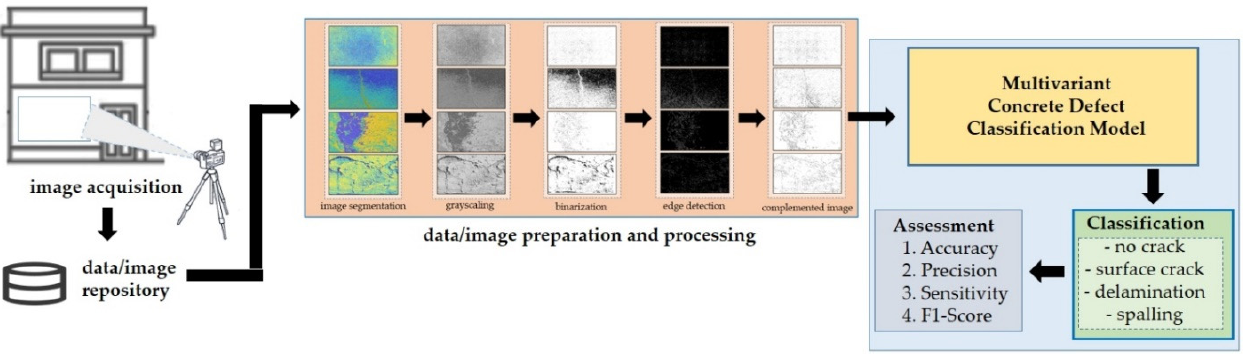
Figure 6. The proposed scheme of the study.